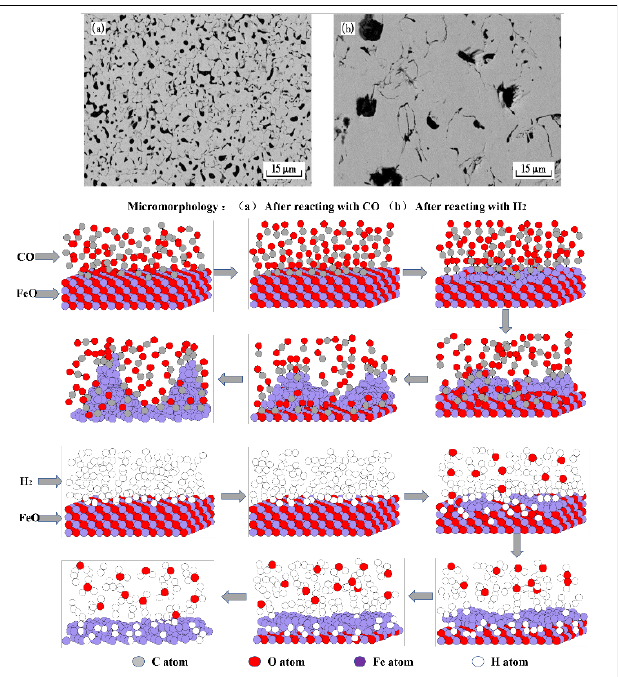
Figure 2. Microstructure of iron oxide reacting with CO and H 2, adapted from [42,47]. ( a ) After reacting with CO; ( b ) After reacting with H 2 .